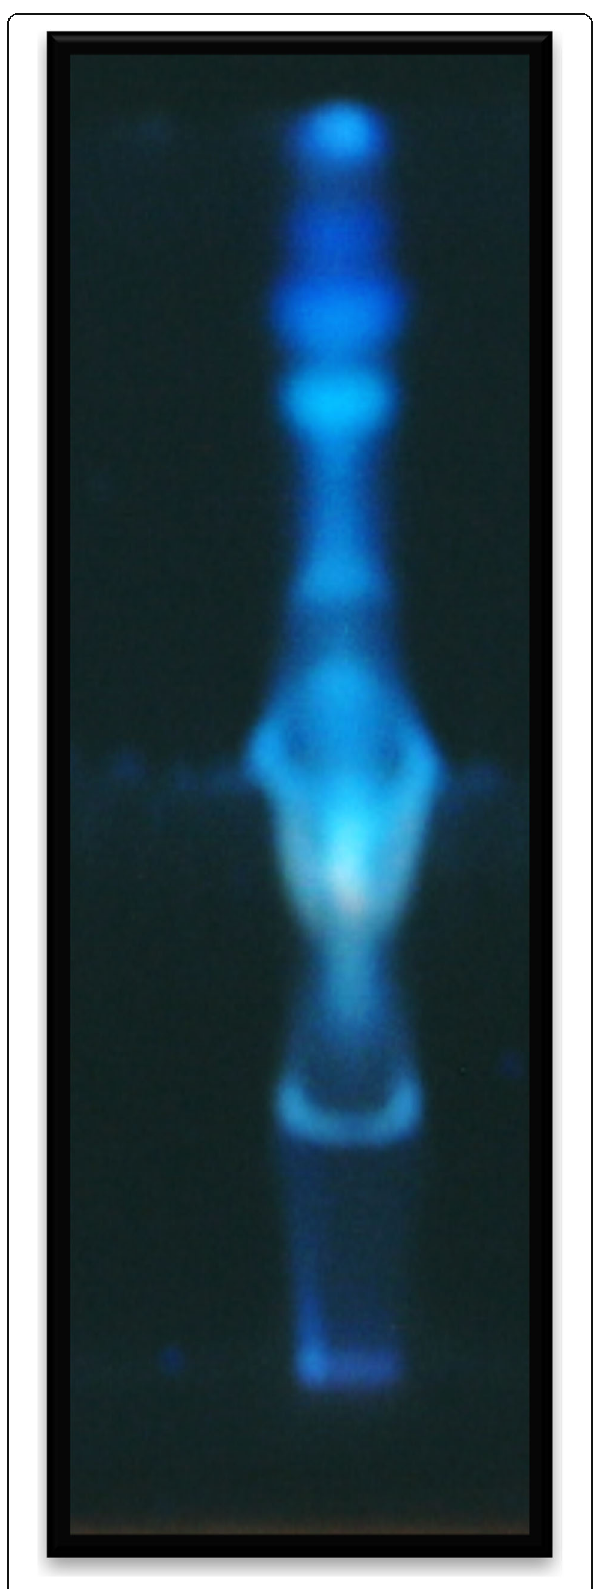
Fig. 2 HPTLC analysis of ethyl acetate extract of C. epigaeus